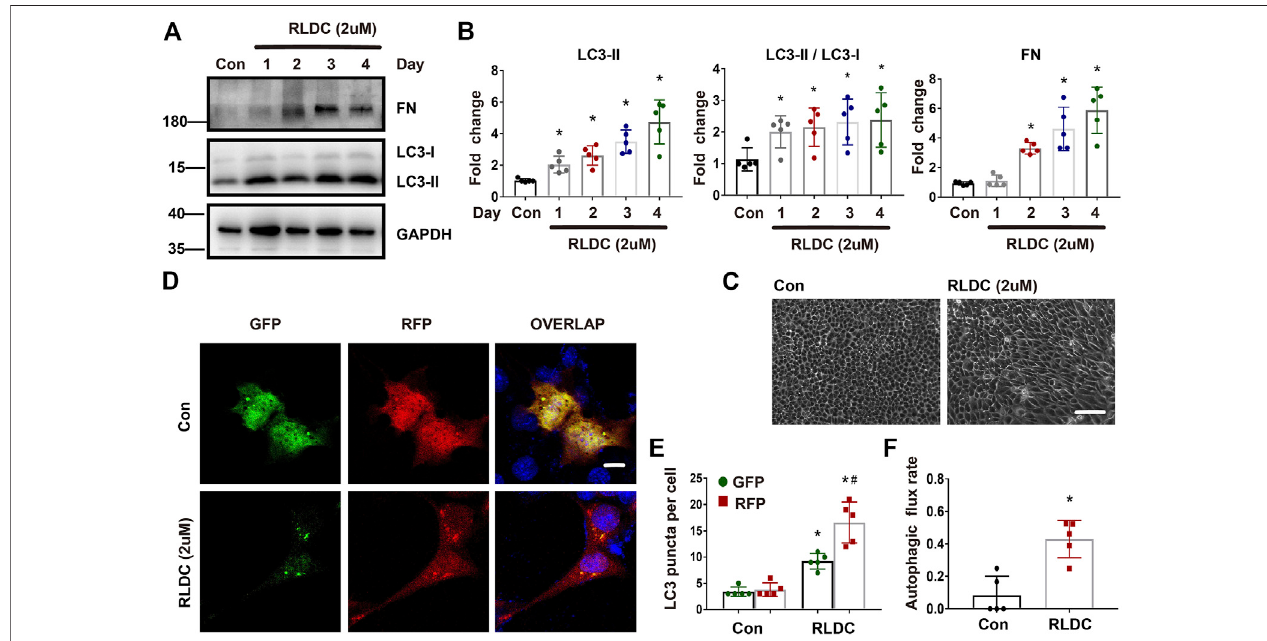
FIGURE 4 | RLDC treatment induces autophagy and fi brotic phenotypes in BUMPT cells. BUMPT cells were incubated with 2 μ M cisplatin for 7 h each day for 4 days(RLDC)orwithoutcisplatinexposure(Con). (C – F) . (A) RepresentativeimmunoblotsofFN,LC3-I,LC3-IIandGAPDH(loadingcontrol)incellsafterdifferentcycles of cisplatin treatment. ( n = 5). (B) Densitometry of FN and LC3-II, LC3II/LC3I. The experiments were normalized according to GAPDH expression. The protein level of control group (Con) was arbitrarily set as 1, and the signals of other conditions were normalized with the control group to indicate their protein fold changes. (C) Morphologies of control and RLDC-treated cells. (bar= 50 μ m). (D) BUMPT cells were transiently transfected with mRFP-GFP-LC3.RFP and GFP fl uorescence images were collected at 24 h after transfection by confocal microscopy. (E) The numbers of GFP-LC3 puncta per cell and RFP-LC3 puncta per cell were counted separately using ImageJ. The number of autophagosomes is represented by GFP dots, and the number of autolysosomes was obtained by subtracting GFP dots from RFP dots. ( n = 5). (F) Autophagic fl ux rate. ( n = 5). Quantitative data are expressed as mean ± SEM. * p < 0.05 vs the control group